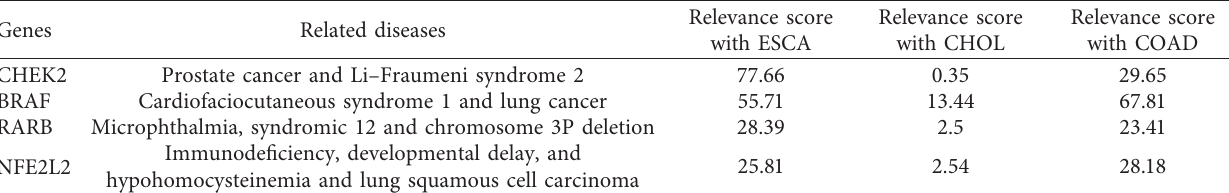
Table 6: Co-DEGs identified by SG-jNMF of ESCA, CHOL, and COAD.